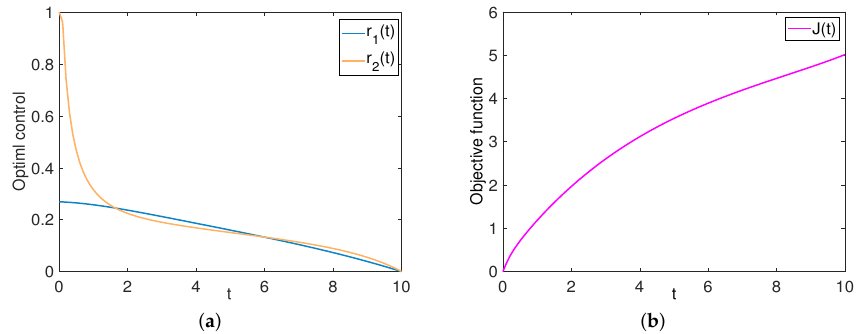
Figure 19. ( a ) The trajectories of r i ( t ) i = 1,2. ( b ) The trajectory of control cost J ( t )